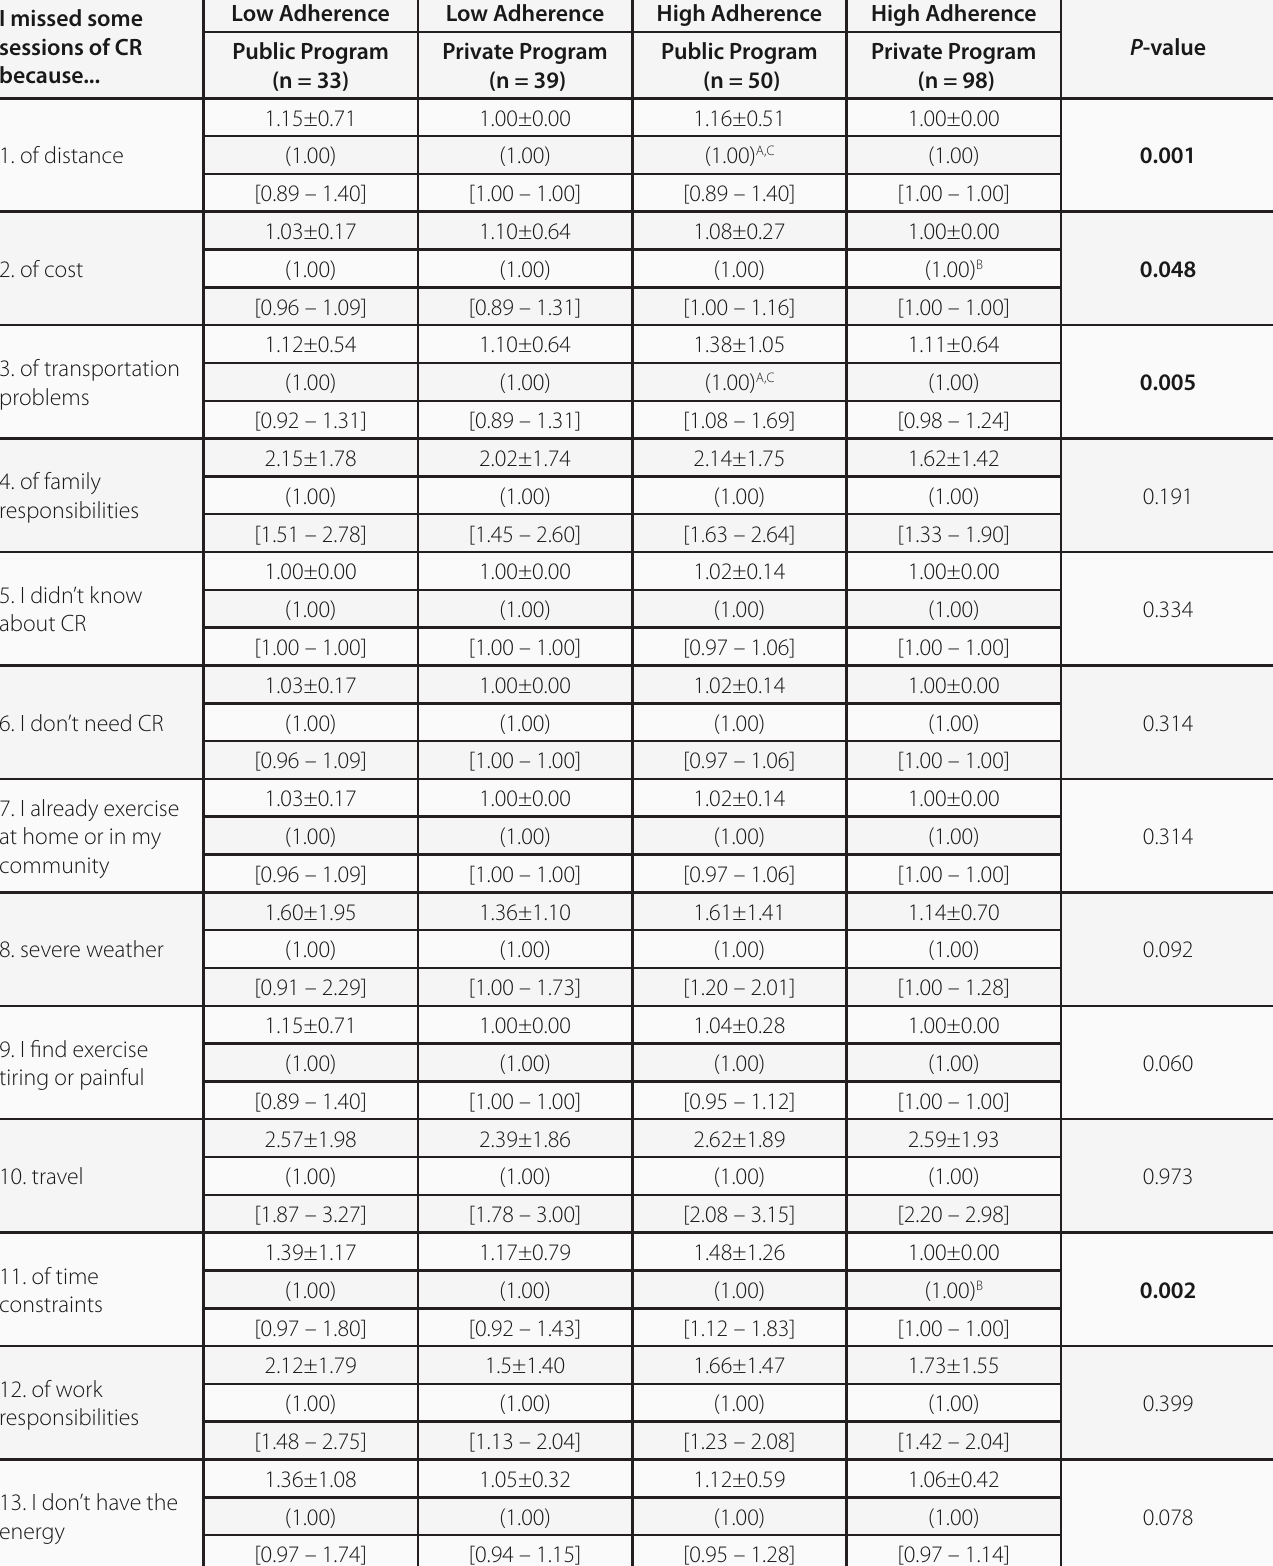
Table 4. Questions about the Cardiac Rehabilitation Barriers Scale